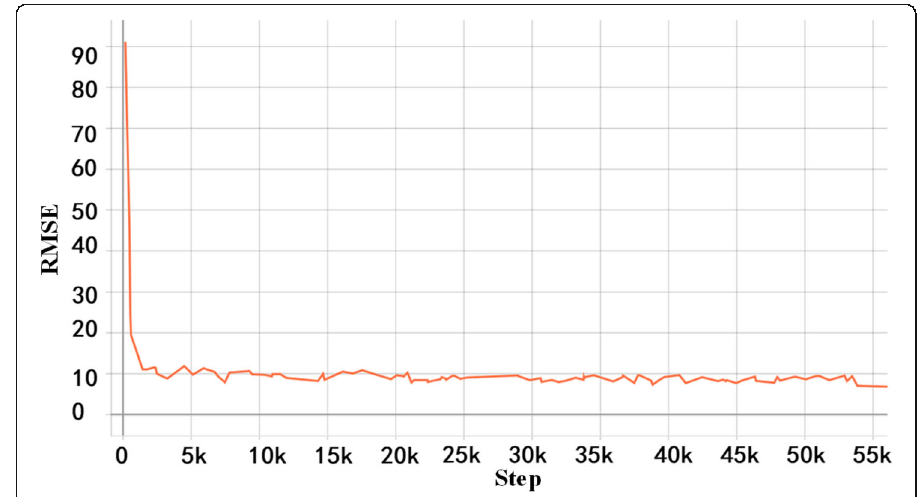
Fig. 6 Model training results